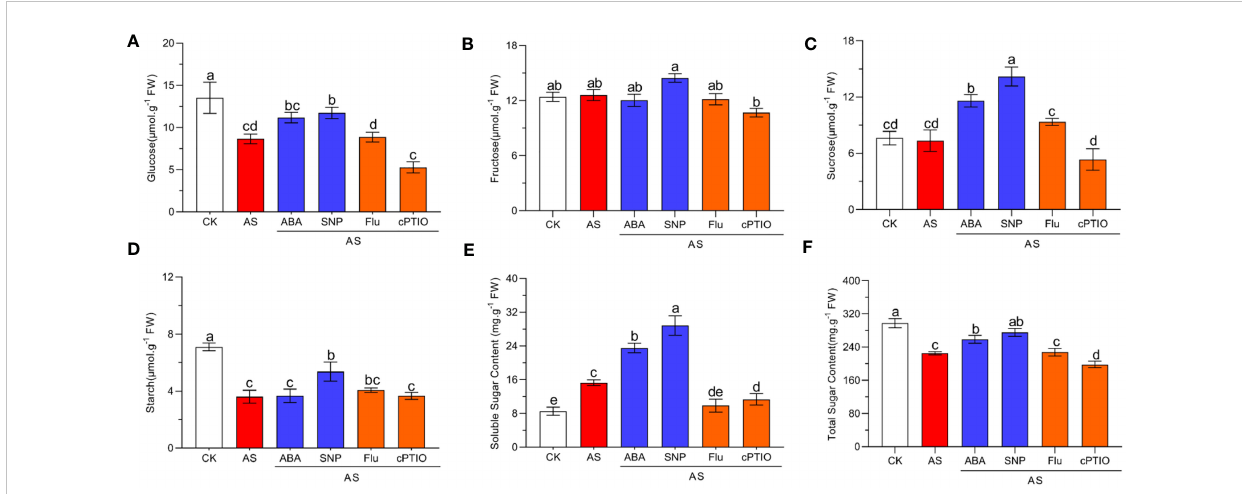
FIGURE 6 Effects of different treatments on sugar accumulation in N. tangutorum seedlings. 40-day-old seedlings were treated with different treatments (100 mM alkali, 100 mM alkali +15 m m ABA/5 m m Flu, 100 mM alkali +50 m m SNP/70 m m cPTIO) for 12 days(AS: NaHCO 3 : Na 2 CO 3 = 9:1, pH=9.5). Plants grew in Hoagland solution served as controls (CK). (A – F) : Changes in the accumulation of carbohydrates in leaves of N. tangutorum seedlings under different stress treatments, in order: glucose, fructose, sucrose, starch, soluble sugar and total sugar. Bars represent the means ± SDs of three replicates. Signi fi cant differences among treatments are indicated by different letters within a panel based on Duncan ’ s multiple range test ( P <